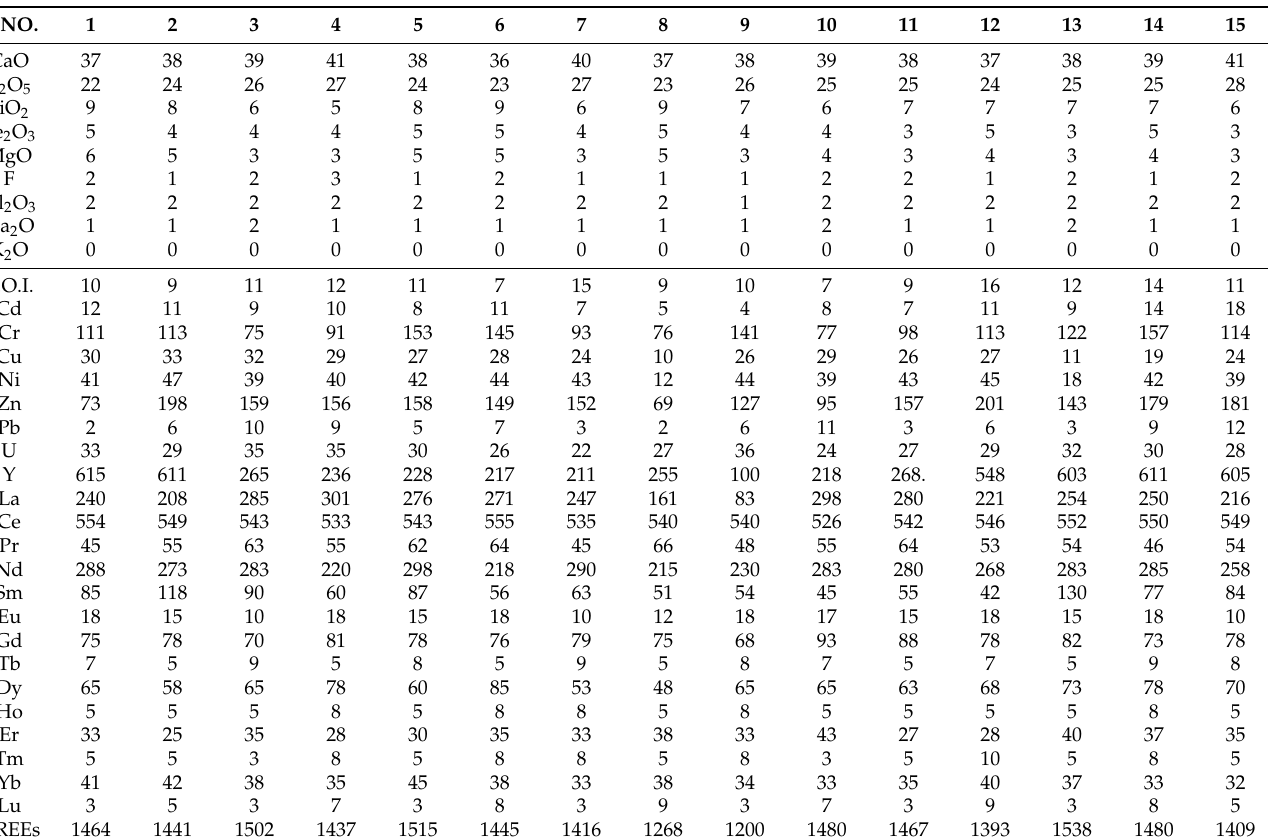
Table 1. Whole rock {major (wt.%), trace (ppm), and REEs (ppm)} analysis of Gebel Qulu El Sabaya phosphorite samples.